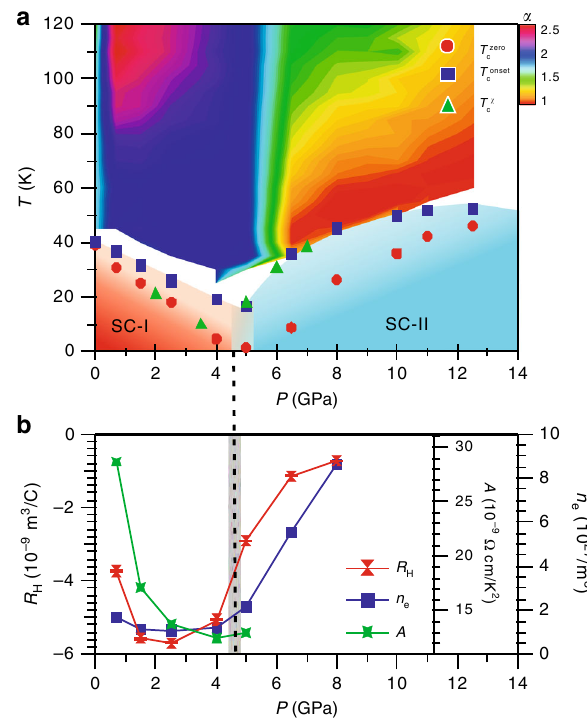
Fig. 2 T – P phase diagram of (Li 1 − x Fe x )OHFe 1 − y Se with an ambient-pressure T = 40 K. a Pressure dependence of the superconducting transition c temperatures T c s and a contour color plot of the normal-state resistivity exponent α up to 12.5 GPa. The values of T c onset , T c zero , and T c χ